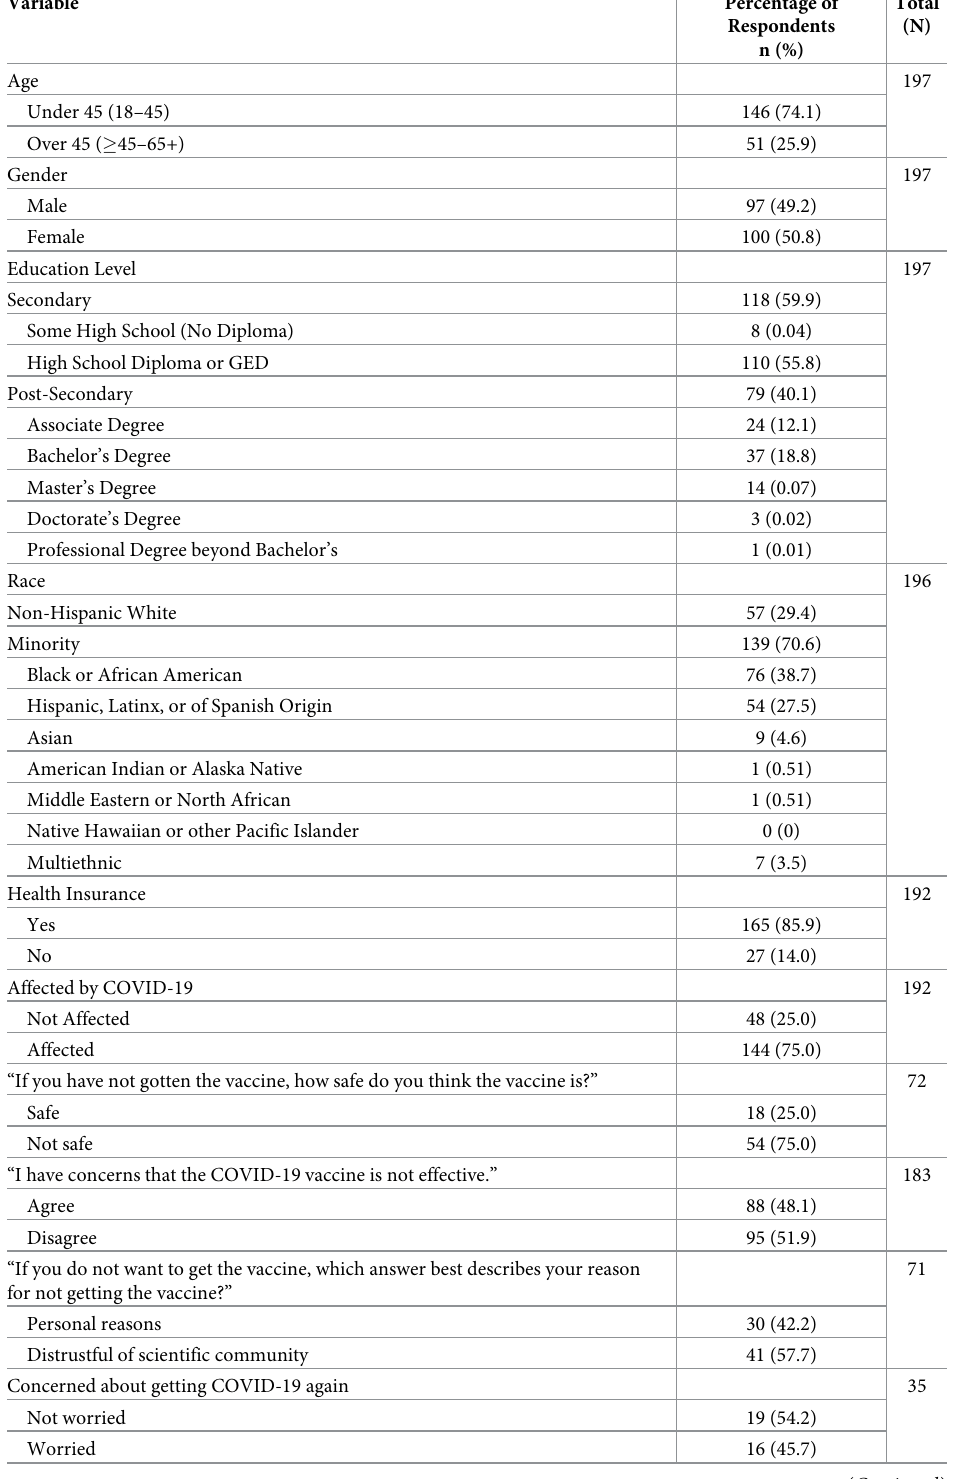
Table 1. Demographics of participants in eastern Pennsylvania completing a survey of COVID-19 vaccination